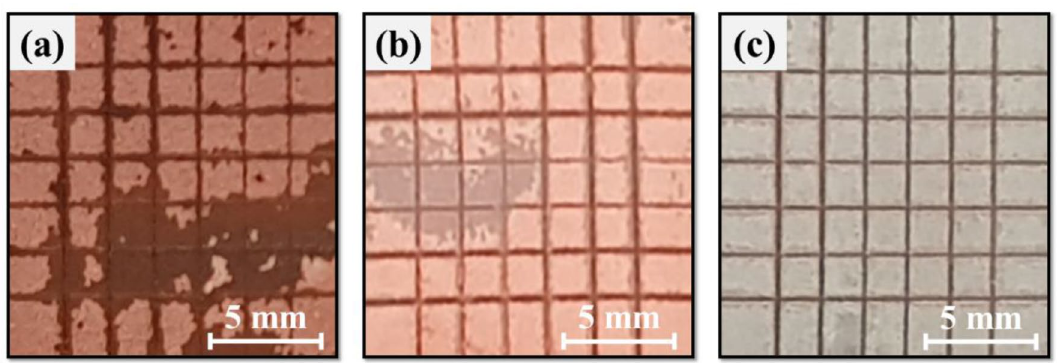
Figure 9. ASTM D 3359 Adhesion test for an ( a ) IPL sintered Cu NP electrode, ( b ) IPL sintered CPN electrode, and ( c ) Ni electroplated CPN electrode (S-16).